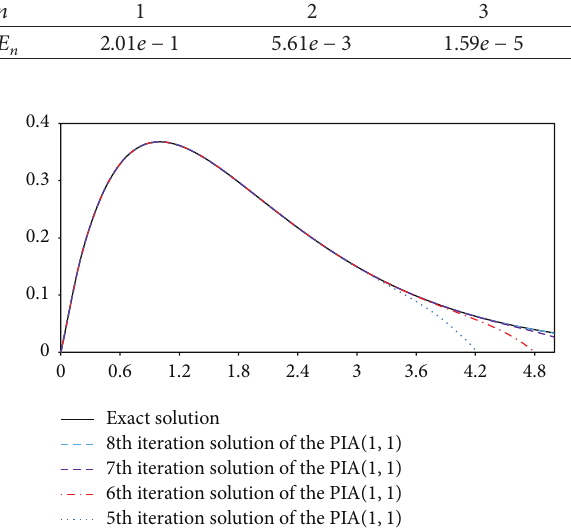
Figure 5: Comparison of the iteration solutions of the PIA (1, 1) method with the exact solution for example 5.